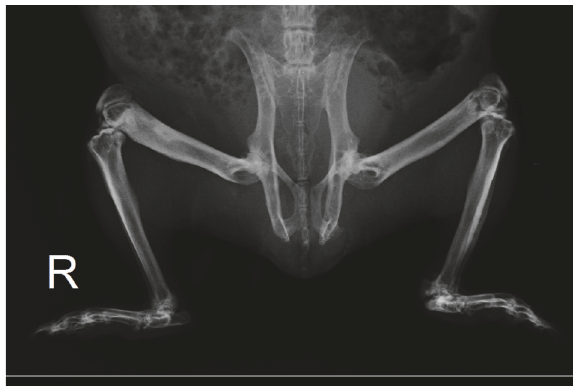
Figure 2: Ventrodorsal view of the rear third of a 4.5-year-old guinea pig with fibrous osteodystrophy in which hyperostosis, scle- rosis, and partial remodeling are observed in previously decalcified bones. The long-term treatment was based on performing dental